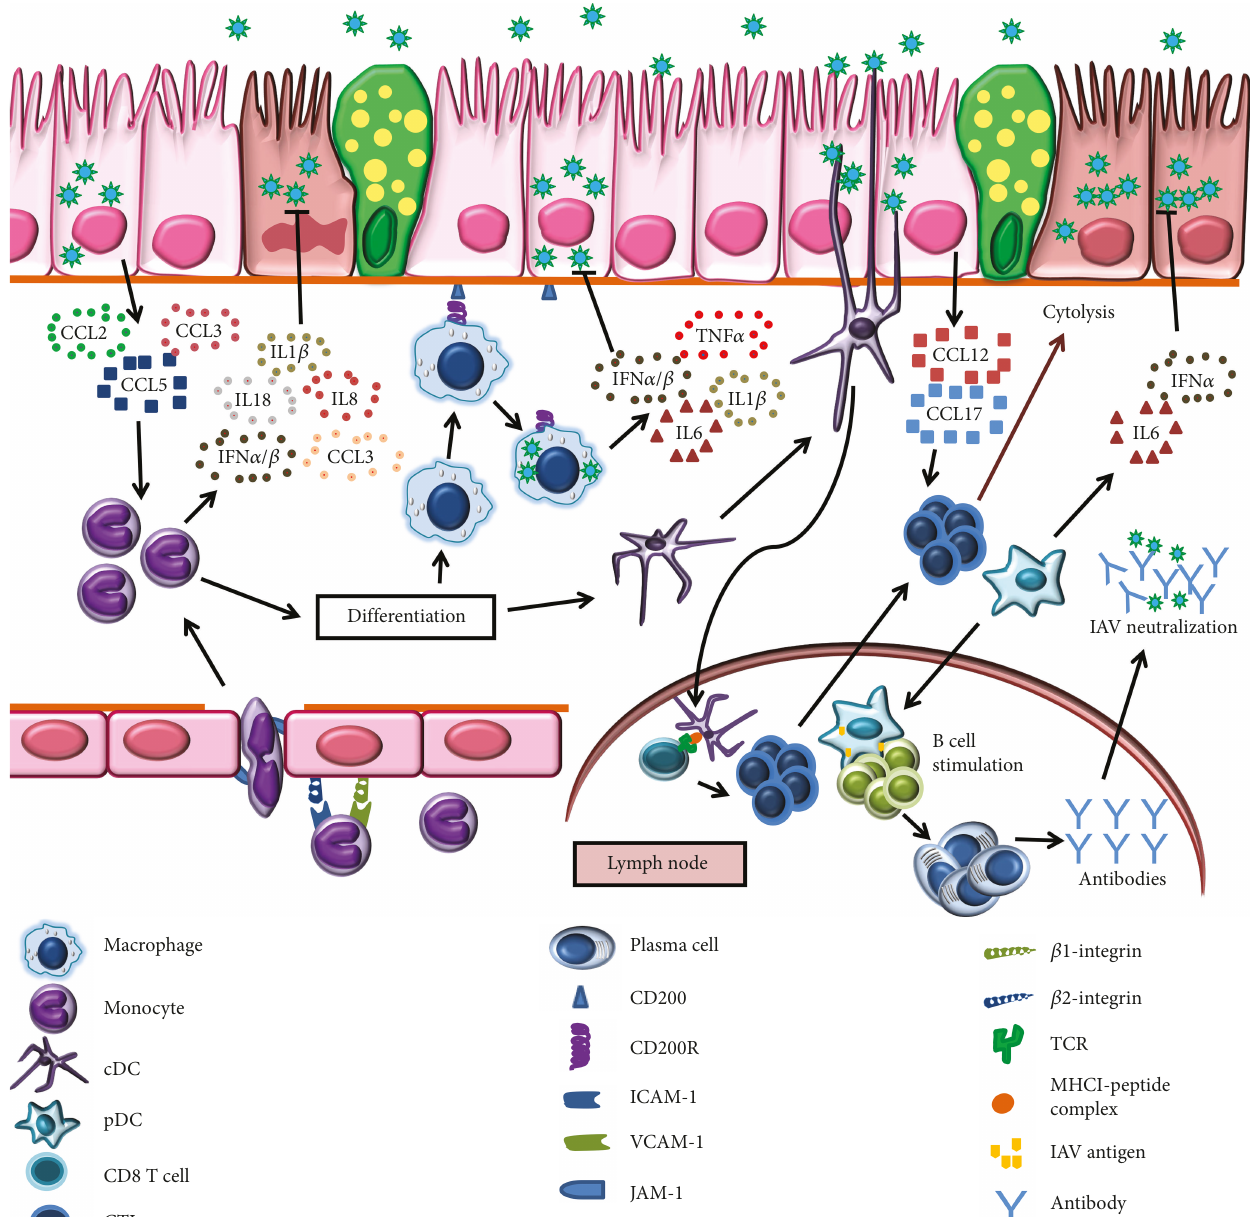
Figure 2: Schematic representation of monocyte-, macrophage-, and dendritic cell- (DC-) controlled immunoprotection and immunopathology during in fl uenza virus infection. In fl uenza A virus- (IAV-) infected airway epithelium produces monocyte chemoattractants: CCL2, CCL3, and CCL5. Monocytes interact with endothelium through β 1 integrin, VCAM-1, and β 2 integrin, ICAM- 1, binding, and subsequent entry into the lung tissue is assisted by JAM. These activated monocytes secrete in fl ammatory cytokines that inhibit IAV replication. Monocytes exert anti-IAV activity by di ff erentiating into phagocytic cells like macrophages and DCs. IAV infection downregulates CD200-CD200R activating macrophages. These activated macrophages release an array of in fl ammatory cytokines that limit IAV replication. Both conventional and plasmacytoid DCs (cDCs and pDCs) exert anti-IAV activity in lungs. IAV- activated cDCs migrate to lymph node and present antigen to CD8 + T cells. Chemokines, CCL12 and CCL17, secreted by infected airway epithelium provide signals for the activated cytotoxic T cells tra ffi cking into the lungs where they lyse IAV-infected cells. The other DC subset, pDC migrate to lymph node and stimulate B cell di ff erentiation into antibody secreting plasma cells. These antibodies neutralize IAV particles conferring humoral